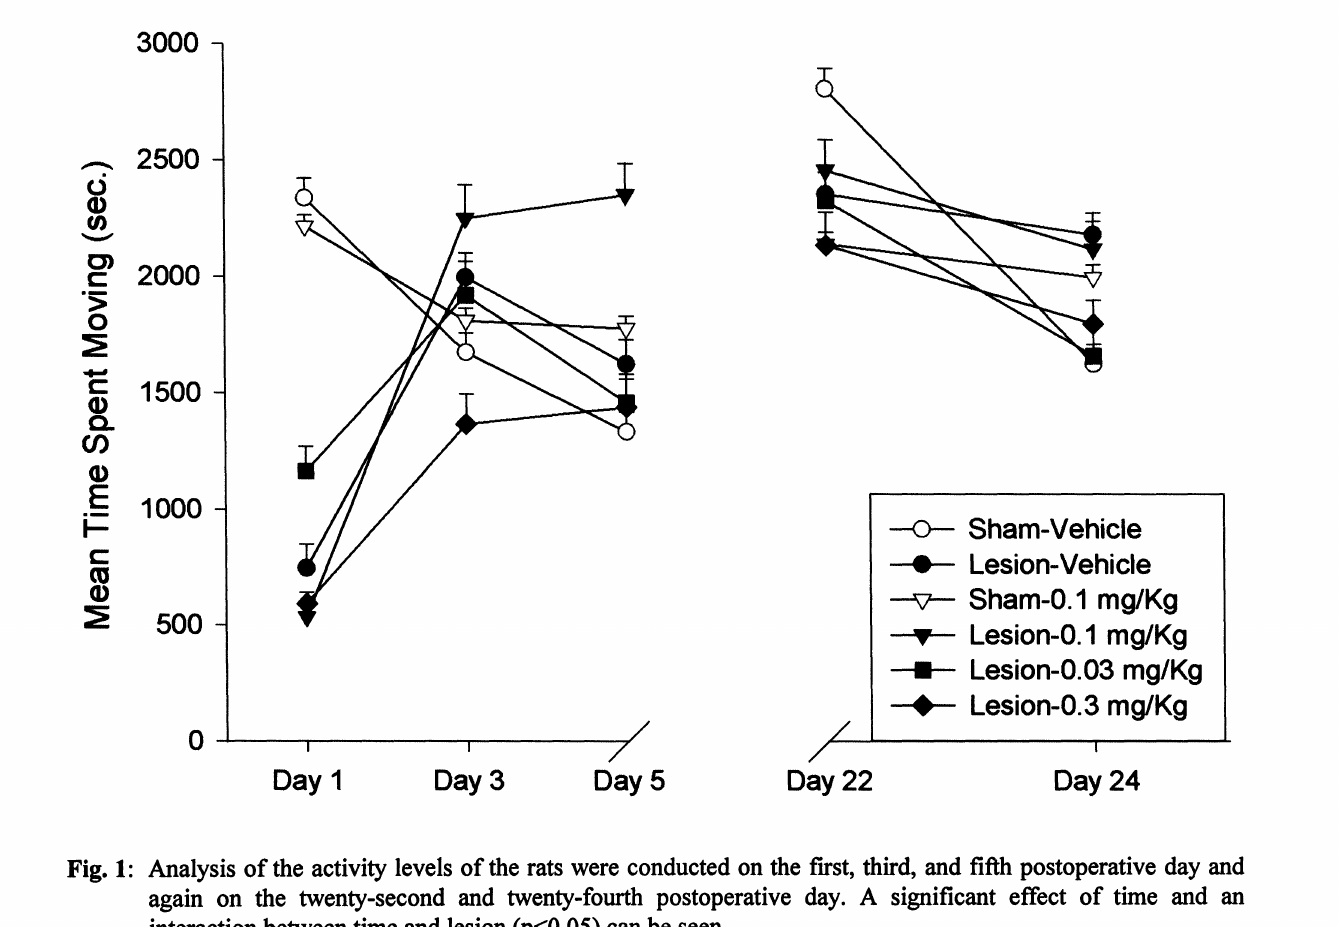
Fig. 1" Analysis of the activity levels of the rats were conducted on the first, third, and fifth postoperative day and again on the twenty-second and twenty-fourth postoperative day. A significant effect of time and an interaction between time and lesion (p<0.05) can be